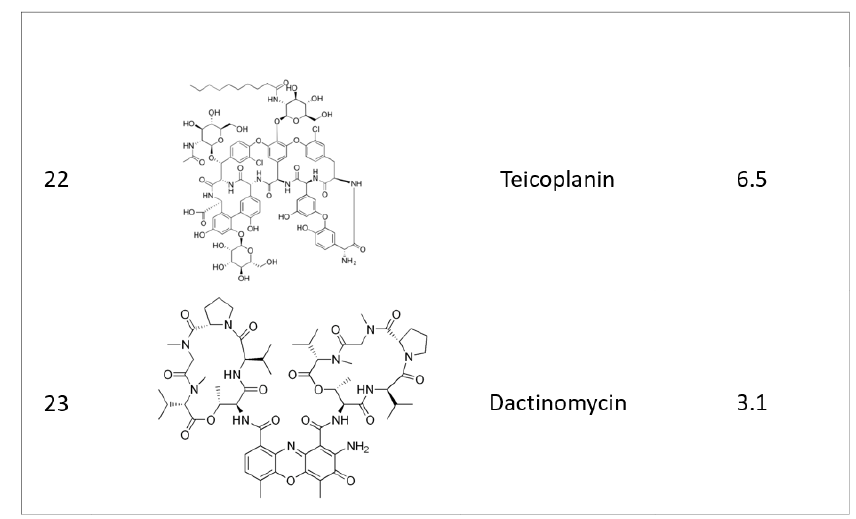
Figure 1. Structure and 50% minimum inhibitory concentration (MIC 50 ) values of the 23 most potent M. abscessus hits.